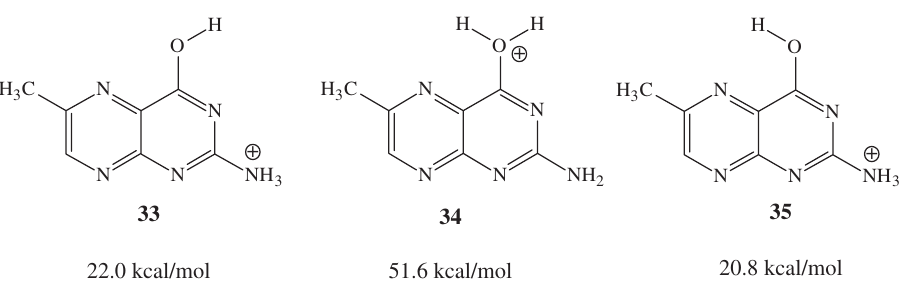
Figure 9 Relative calculated energies of pterins resulting from the non-ring protonation of the two lactim structures, 2 and 3 .